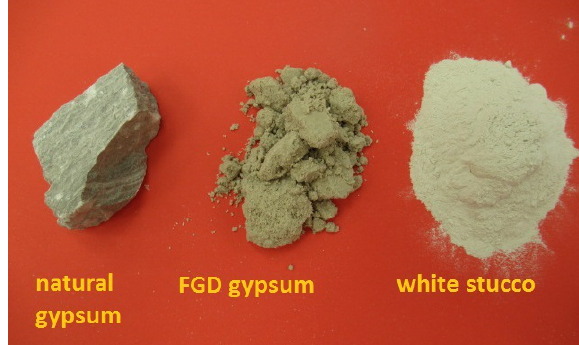
Figure 1. Natural and FGD gypsum, stucco.